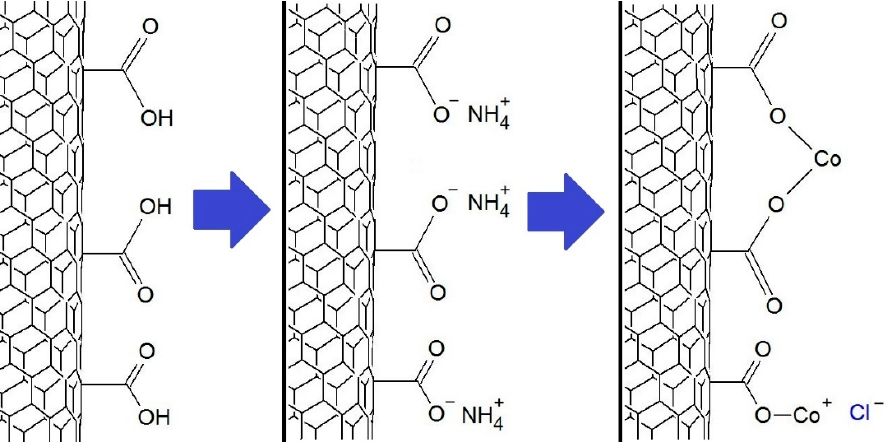
Figure 2. The scheme of the synthesis of MWCNT-COO-M using CoCl 2 salt.